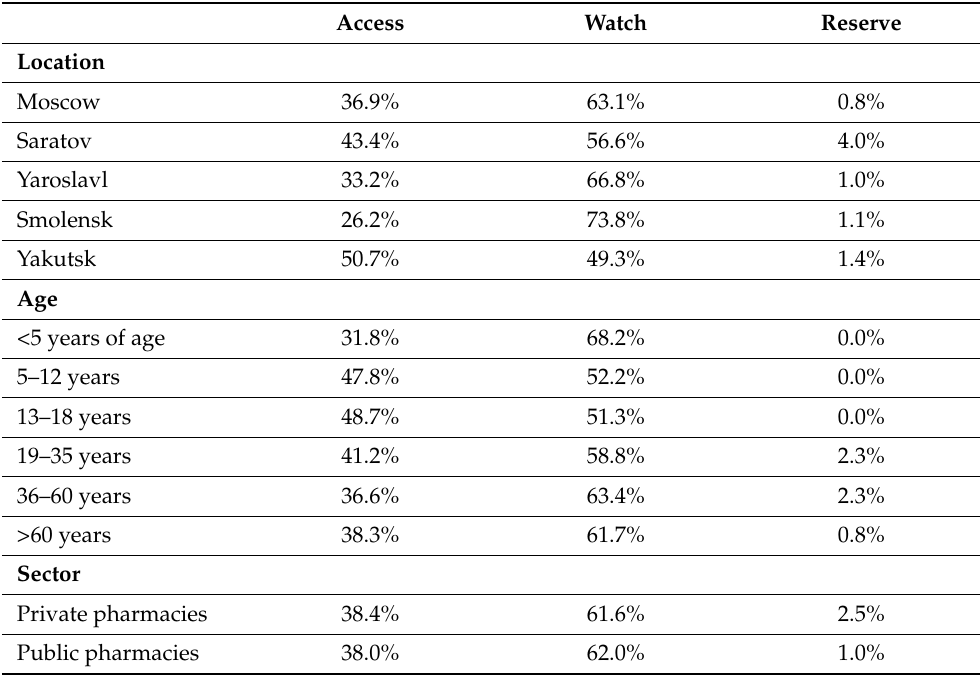
Table 9. Supplies according to the AWaRe classification, % of total